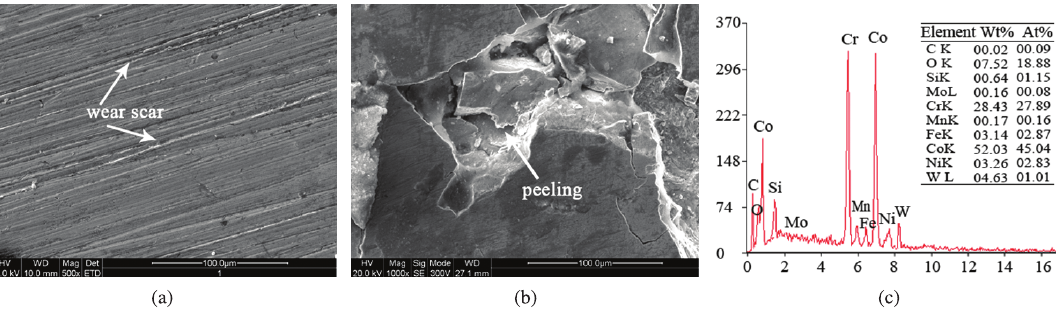
Figure 5. Worn surface morphology and EDS analysis under different load conditions at 0.12 m/s. (a) Worn surface morphology at 4 N, 0.12 m/s; (b) Worn surface morphology at 12 N, 0.12 m/s; (c) EDS analysis of the worn surface at 12 N, 0.12